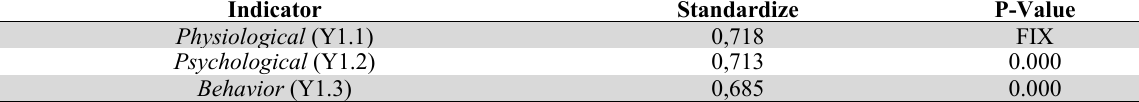
Results of Occupational Stress Measurement Model Examination (Y1)